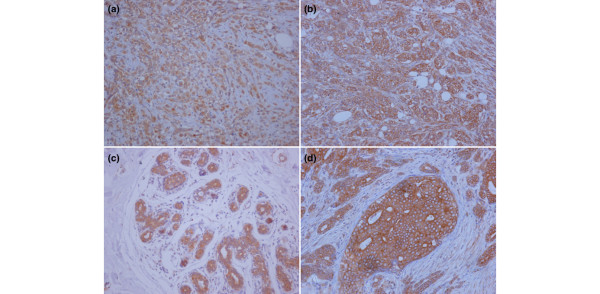
TIMP-3 protein expression in breast cancer and normal epithelium. The micrographs show tissue inhibitor of metalloproteinases (TIMP)-3 in the cytoplasm of a lobular carcinoma (a), both the cancer cells and peritumoral stroma of a ductal carcinoma (b), in situ carcinoma (c) and normal epithelium (d). Envision/horseradish peroxidase staining; original magnification ×200.